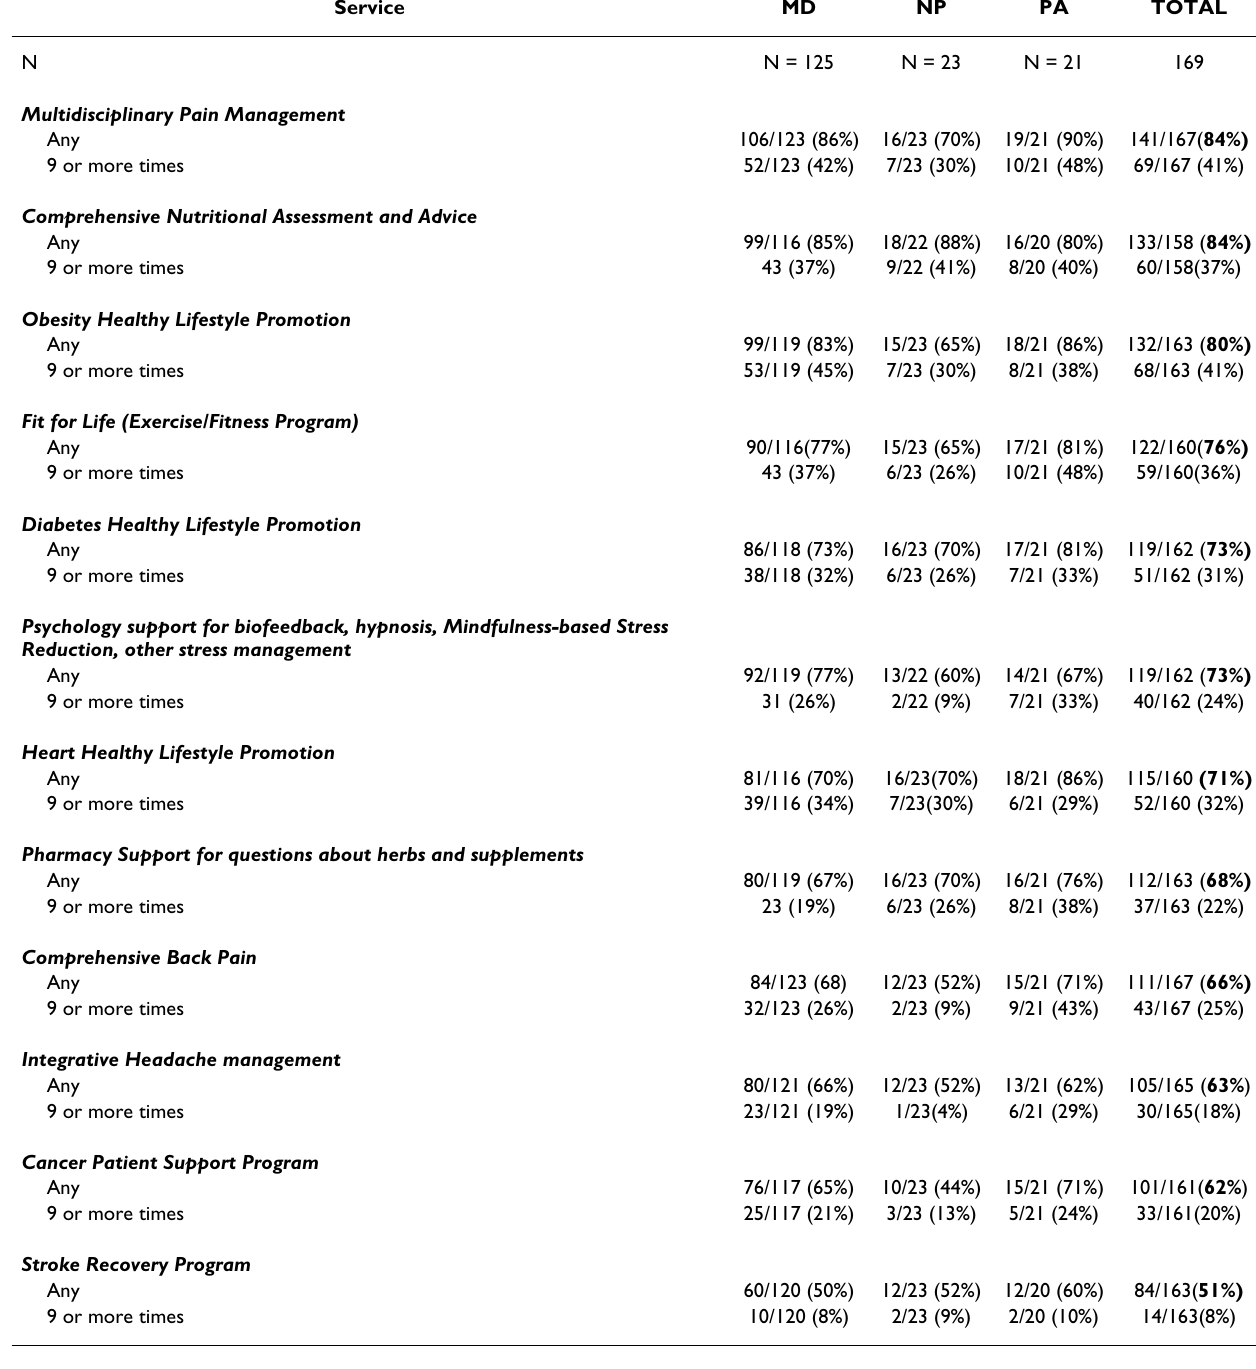
Table 3: Anticipated referrals to comprehensive services offered at WFUBMC in next 12 months